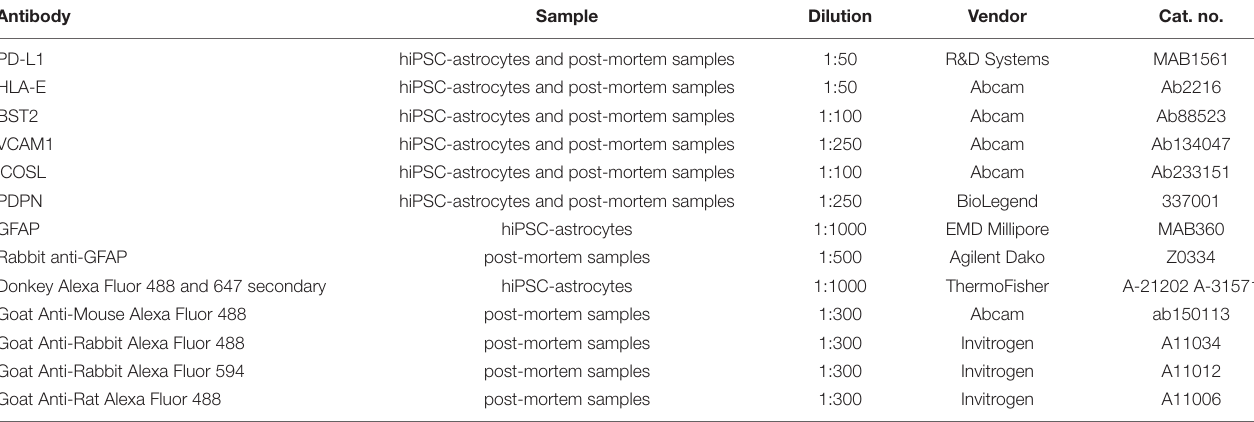
TABLE 3 | Antibodies for immunohistochemistry. Antibody Sample Dilution Vendor Cat. no. PD-L1 hiPSC-astrocytes and post-mortem